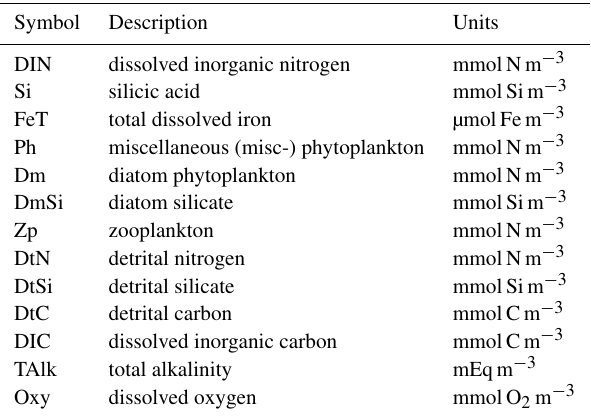
Table 1. Diat-HadOCC model state